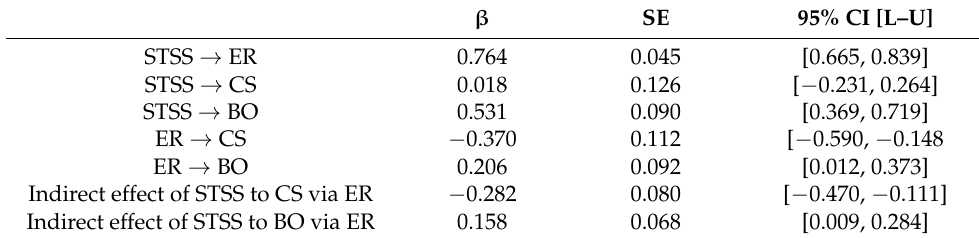
Figure 2. Graphical representation of the structural equation model. Table 3. Mediation model: direct and indirect